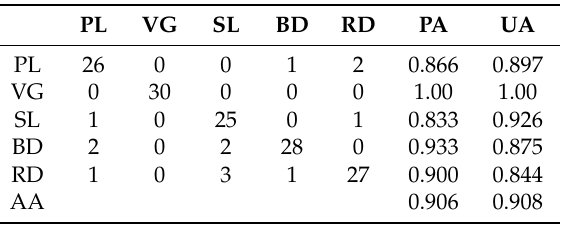
Table 18. Confusion matrix of the SAE in the third area.